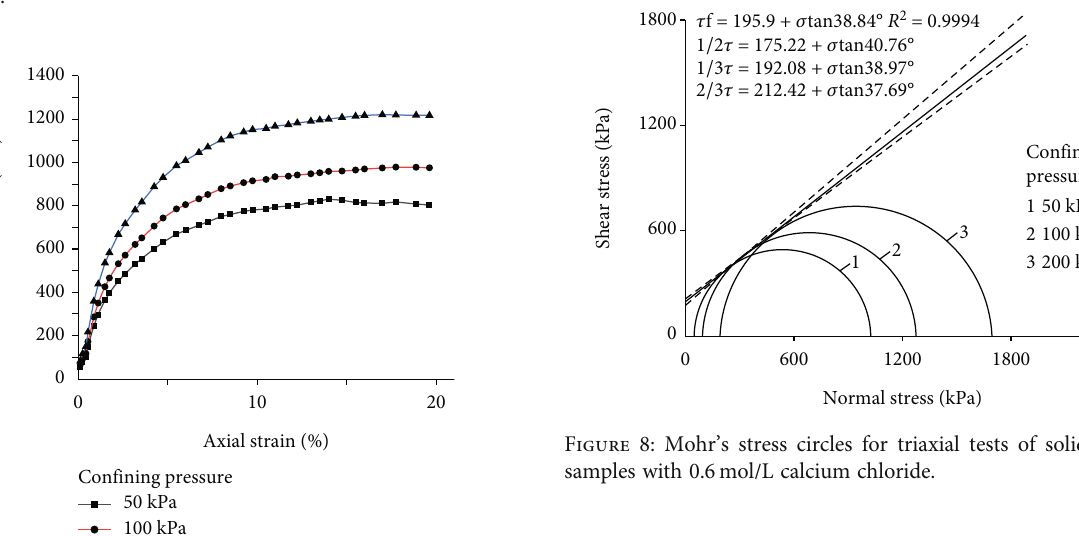
Figure 5: Deviatoric stress-axial strains of solidi fi ed soil samples with 0.6mol/L calcium chloride under di ff erent con fi ning pressures.